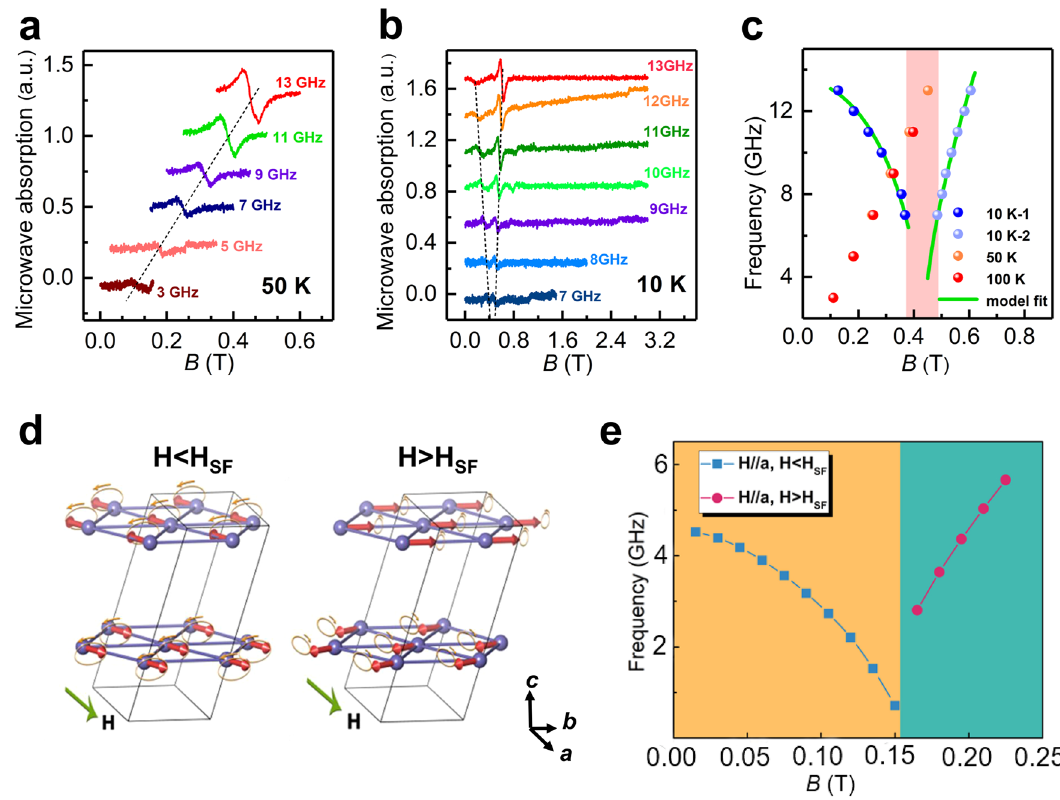
− Lifshitz model. The fi eld interval between two special resonance modes at 10K is markedasshadow,correspondingtotheSFtransition. d Schematicrepresentation ofdifferentmagnonmodesbelowandabovetheSF fi eld. e Thecalculatedmagnon frequency vs magnetic fi eld by